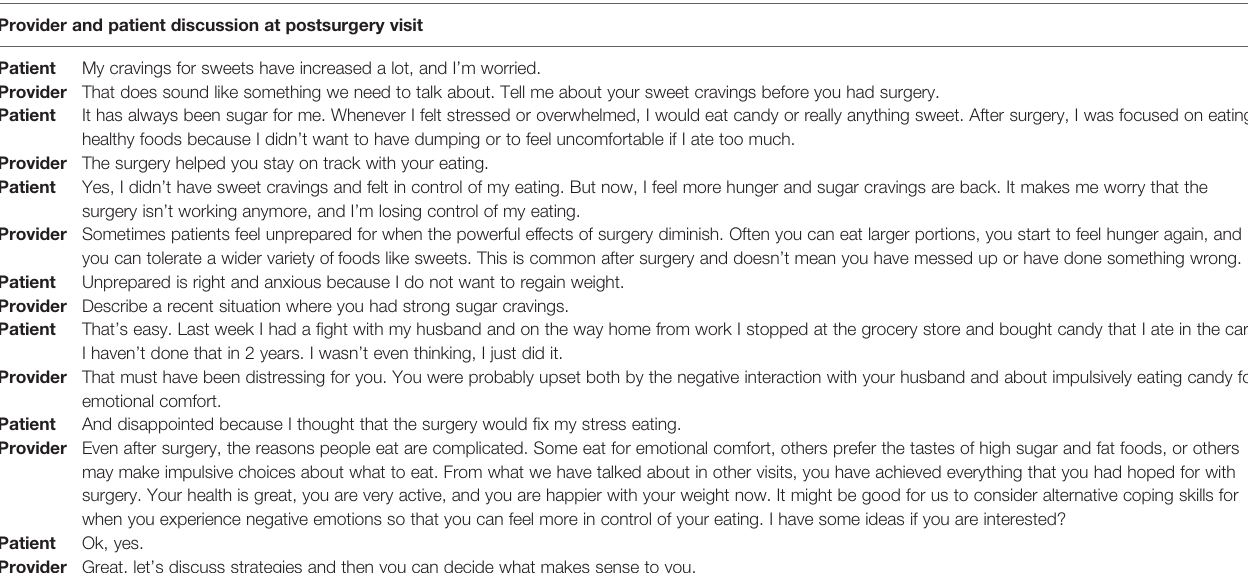
TABLE 2 | Patient vignette for 47-year-old female 18 months post-Roux-en-Y gastric bypass (BMI 27) maintaining 34% reduction in initial body weight. Provider and patient discussion at postsurgery visit